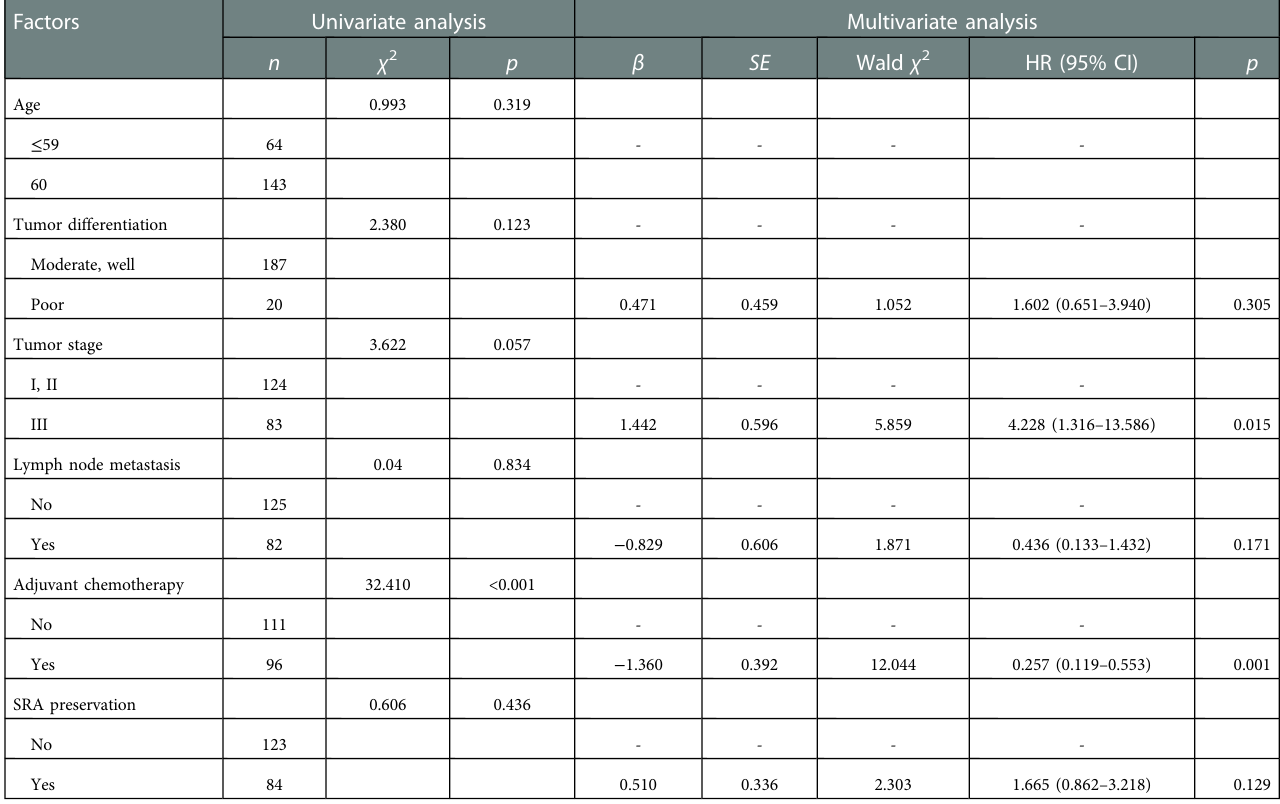
TABLE 3 Univariate and multivariate survival analysis of prognostic factors for patients with SCC.